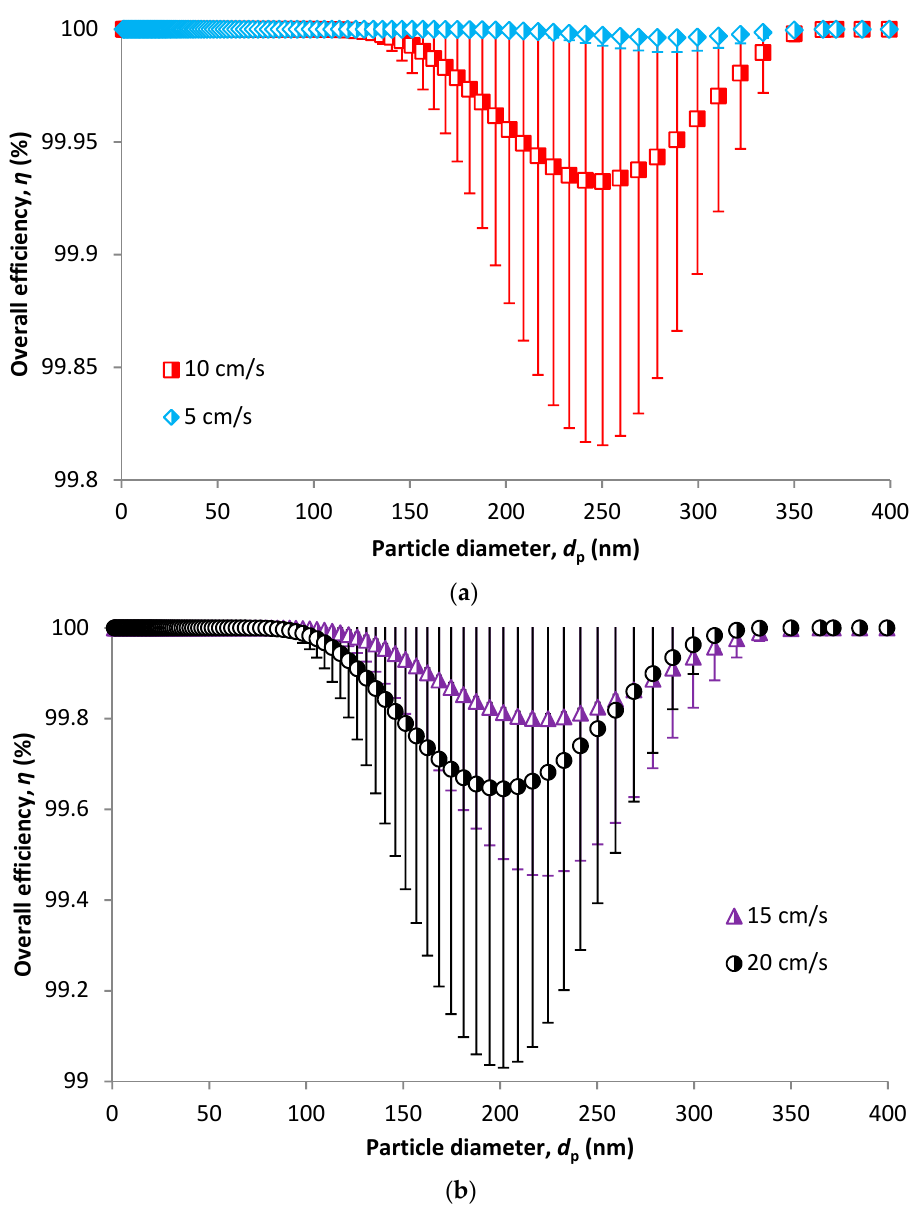
Figure 13. Overall efficiency in relation to particle size based on CPM model for a velocity of 5 and 10 cm/s ( a ) and 15 and 20 cm/s ( b )